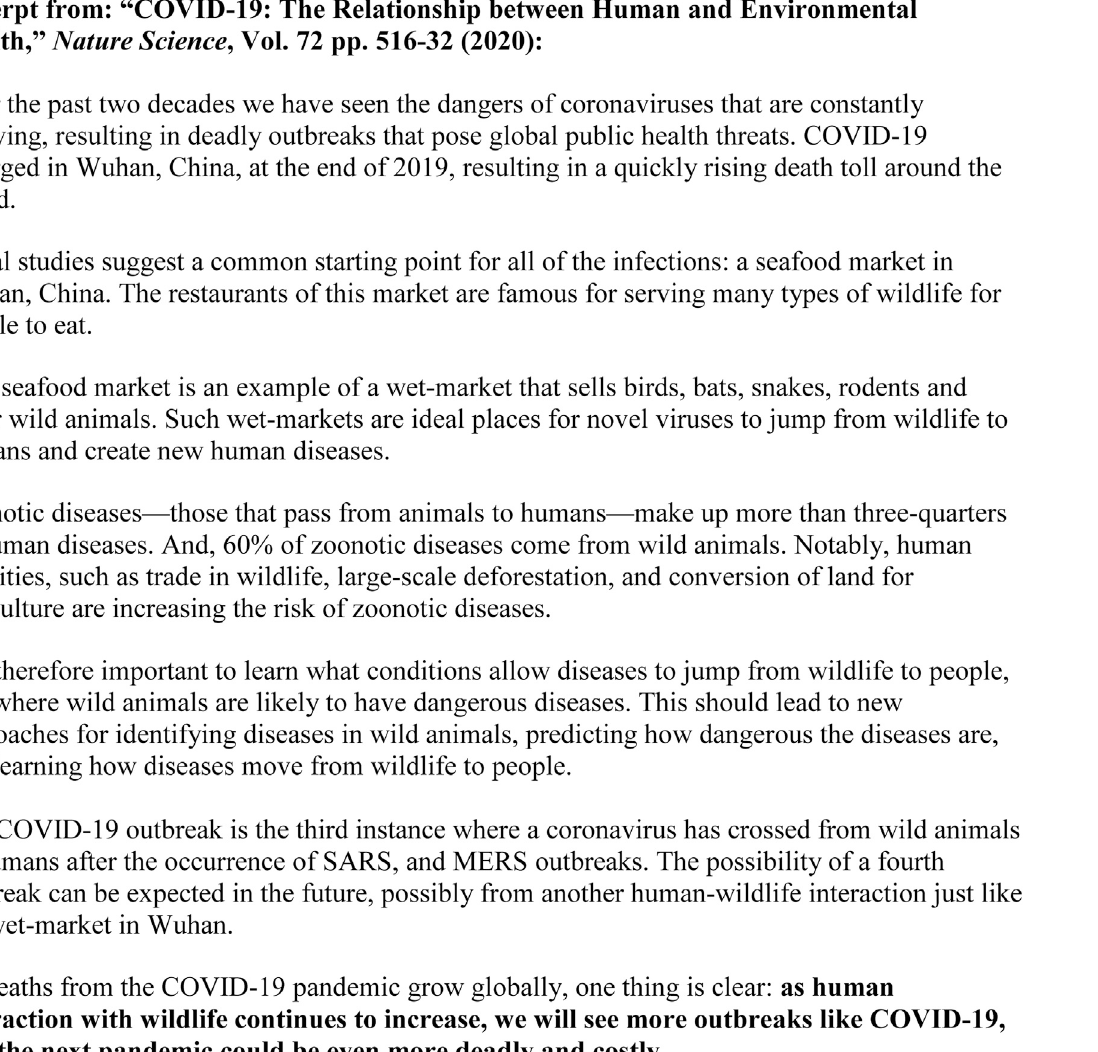
FIGURE 4 | Factually accurate article from a fi ctional ‘ Nature Science ’ academic journal highlighting the science surrounding COVID-19 without cultural framing. Generated by authors with information from Bonilla-Aldana et al. (2020), Mackenzie and Smith (2020), and Rothan and Byrareddy (2020).